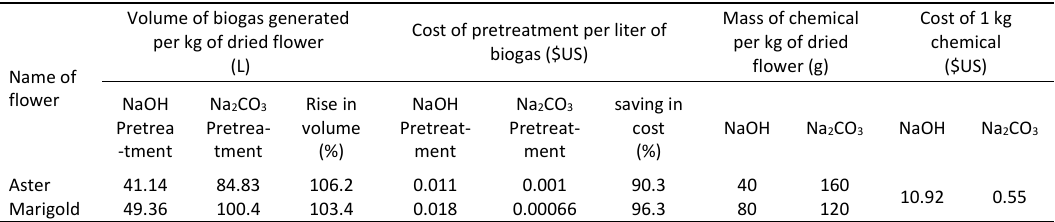
Table 2: Comparison of Sodium Hydroxide and Sodium Carbonate pretreatments for Aster and Marigold flowers